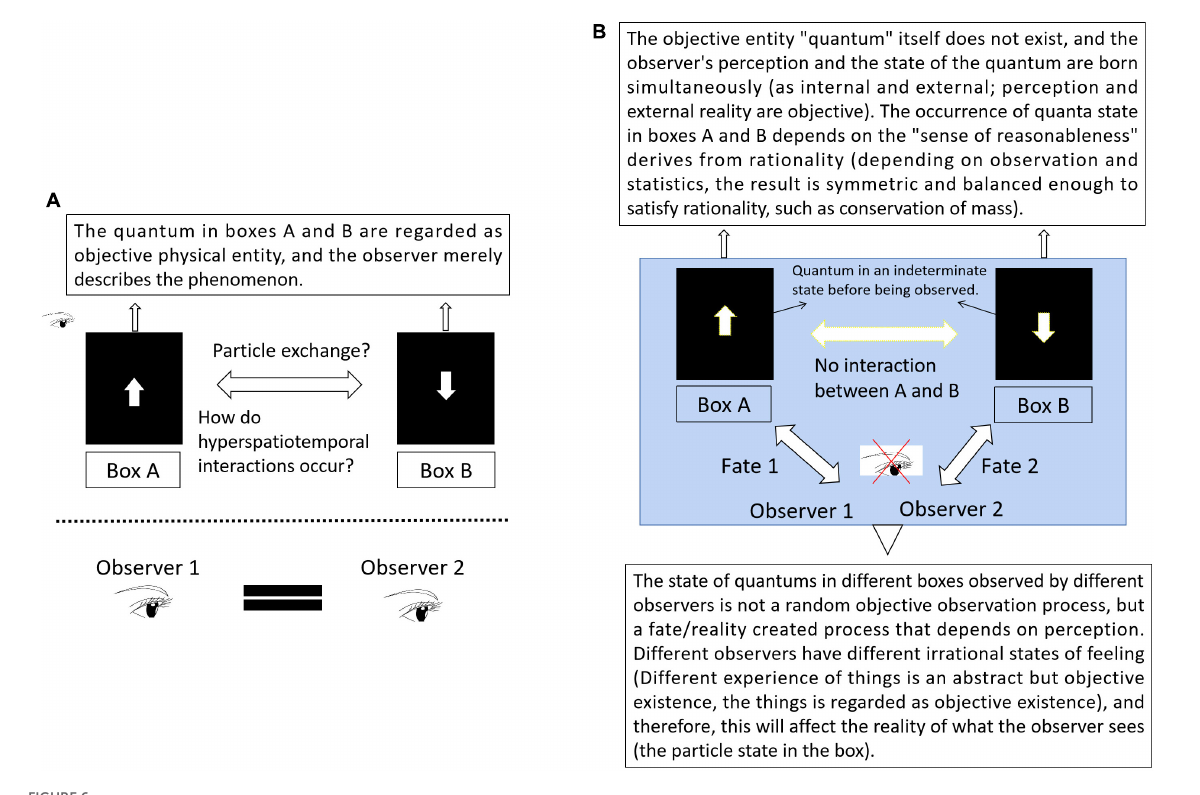
FIGURE6 Interpretation of quantum entanglement based on holistic view. (A) Material view. Based on the difference in external physical form, observer and objects are opposites. External phenomena are irrelevant to the observer (or perception/consciousness). It cannot explain the hypertemporal effects of quantum entanglement. (B) Holistic view. Depending on perception, observer and object are unified. Perception is co-created by subject and object. In other words, what we intuitively regard as subjective, individual and abstract being (experience and feeling) can be described scientifically (Yin-Yang) and used as frame of reference to describe the occurrence of fate or reality of the observers, from the material view, the state of the quantum in boxes A and B is an objective random